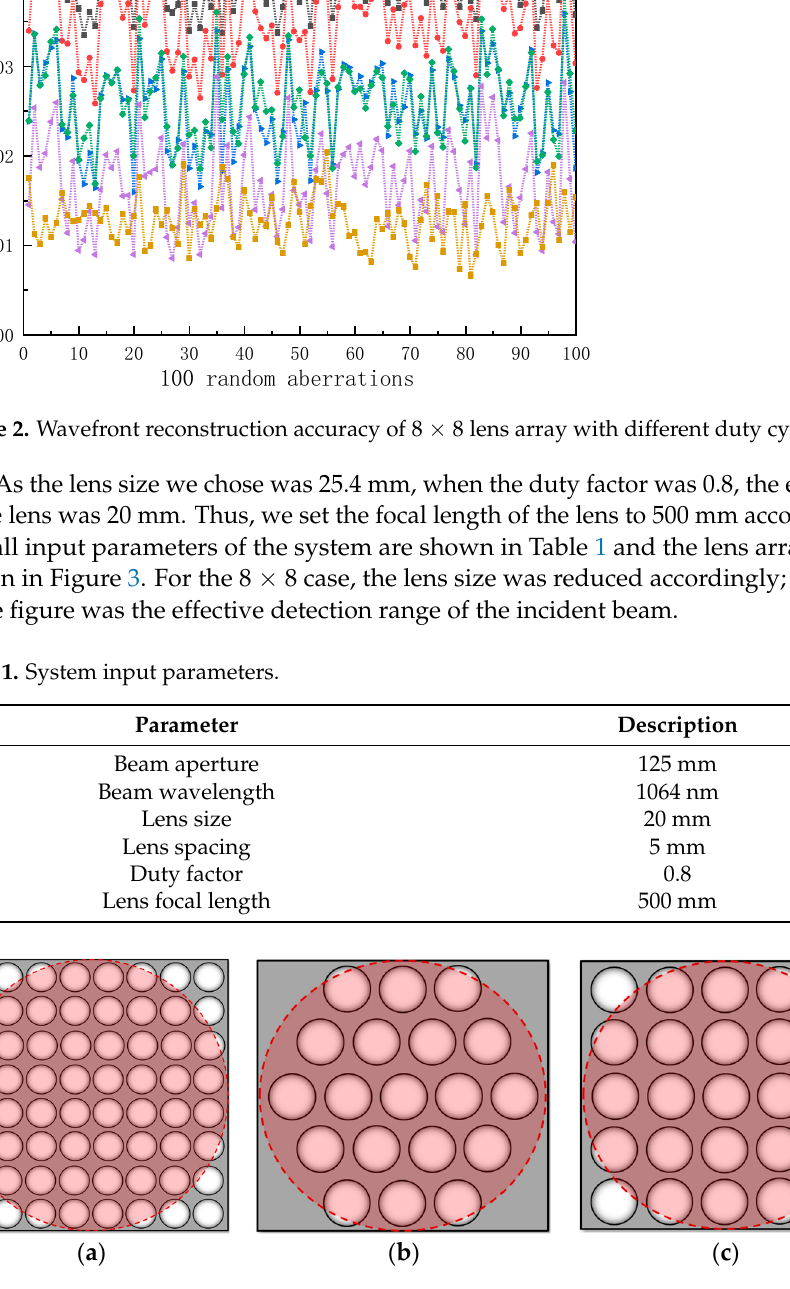
Figure 3. System sub-aperture layout: ( a ) 8 × 8 lens array; ( b ) hexagonal arrangement of 19 lenses; ( c ) 5 × 5 lens array.